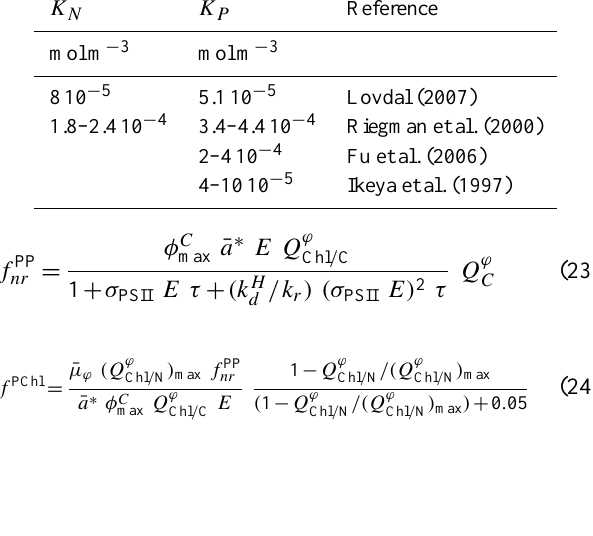
Table 6. Half saturation constants for N and P found in literature for small phytoplankton K N K P